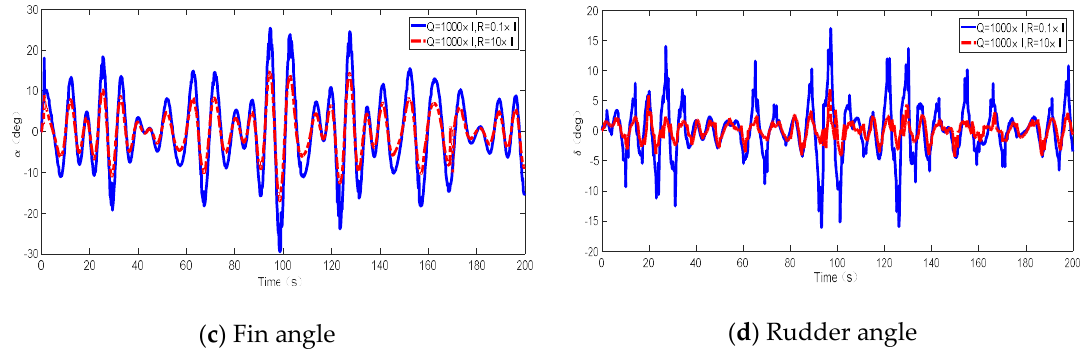
Figure 6. Control performance and the actuator inputs under di ff erent design parameters Q and R . Simulation Case 4: Control performance based on di ff erent models (nominal / uncertain model)